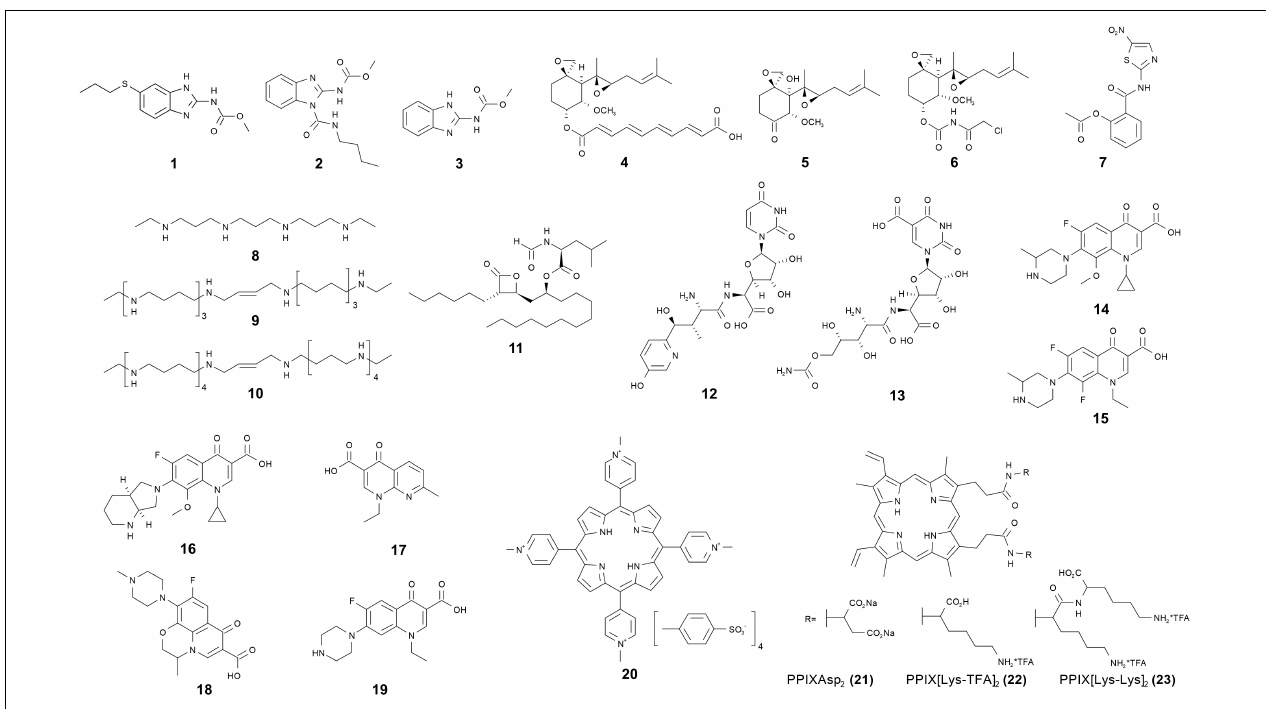
FIGURE 1 | | Chemical structures of antimicrosporidial